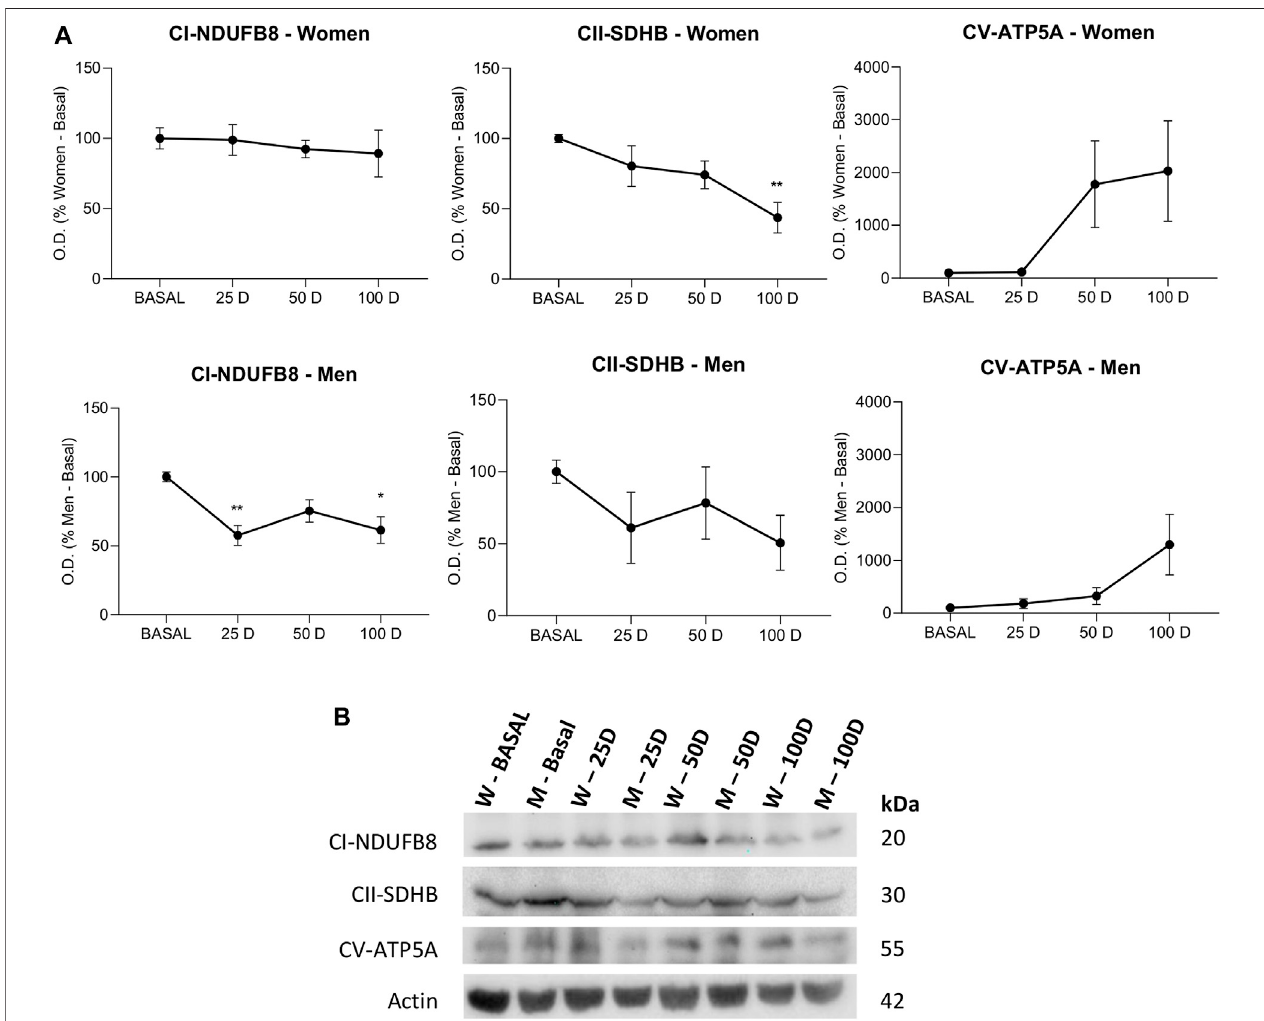
FIGURE5| Westernblotanalysisforstudyingtheproteinlevels ofsubunitsfromcomplexesofthemitochondrialelectron transportchaininlymphocytesextracted fromwomenandmenatbaseline(BASAL),25 days(25D),50 days(50D)and100 days(100D).Barchartshowingtheopticaldensity(OD)(Arbitraryunits)ofblotbands of (A) (NADH dehydrogenase ubiquitone) 1b subcomplex 8 (NDUFB8) from complex I (CI), iron sulfur subunit (SDHB) from complex II (CII) and ATP synthase subunit α (ATP5A)fromcomplexV(CV). (B) Imagesofrepresentativeinmunoblots.Actinwasusedasaloadingcontrol.Dataaremean±SEM.*BASALvs.25,50and100 D. The number of symbols marks the level of signi fi cance: one for p < 0.05 and two for p < 0.01.